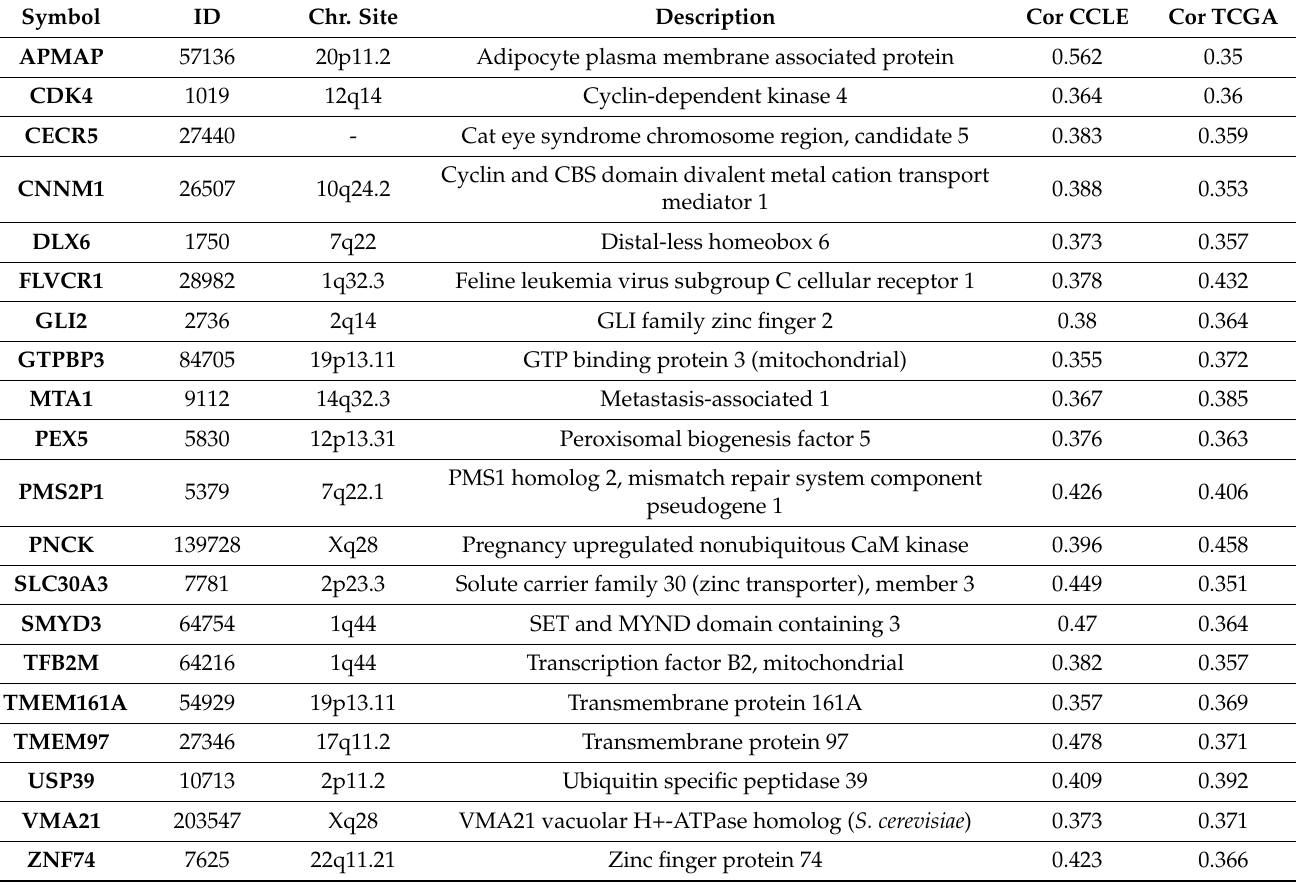
Table 1. List of genes included in the GIN